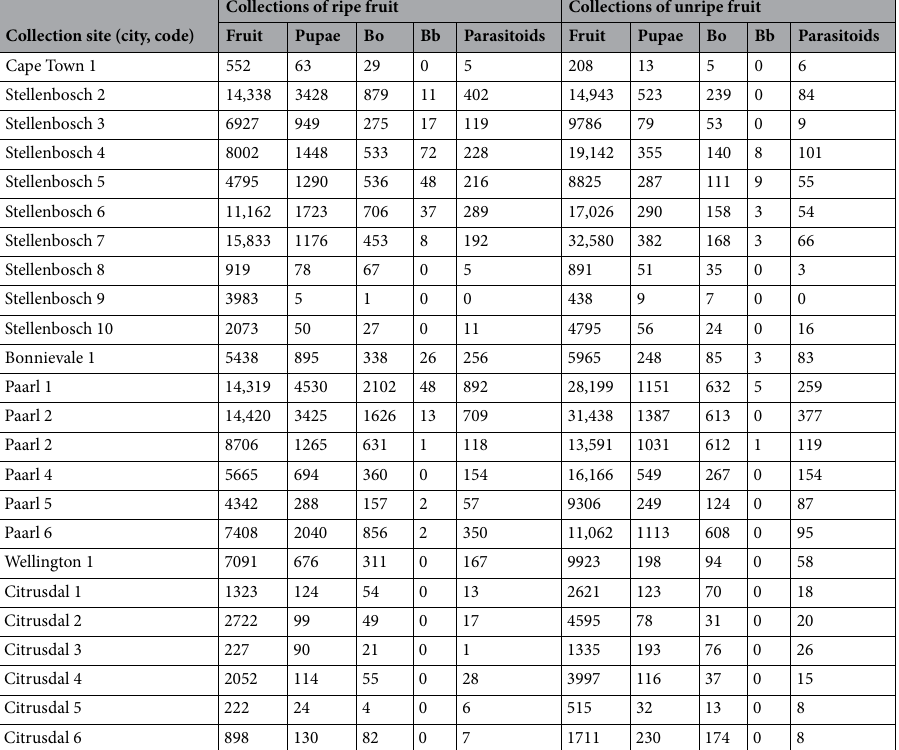
Table 2. Numbers of wild olives collected and fly pupae, adult flies of B. oleae (Bo) and B. biguttula (Bb) and braconid parasitoids emerged from collected unripe and ripe fruit in 26 different sites in the Western Cape, South Africa from October 2004 to February